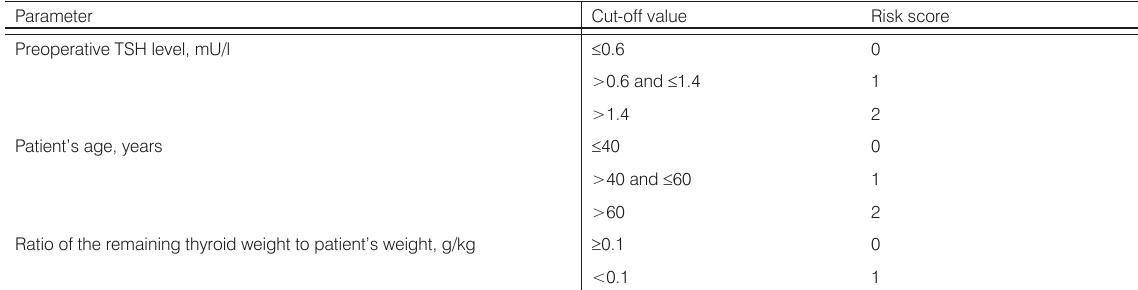
Table 2. Risk scoring system to predict hypothyroidism after hemithyroidectomy.